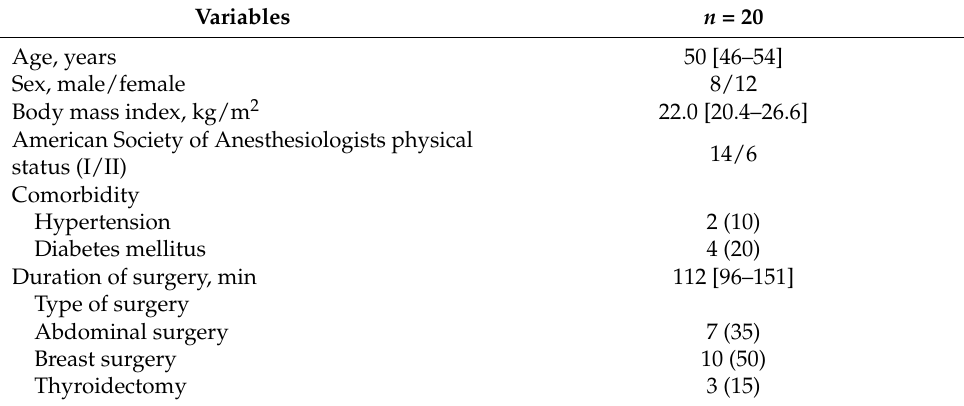
Table 2. Baseline characteristics of